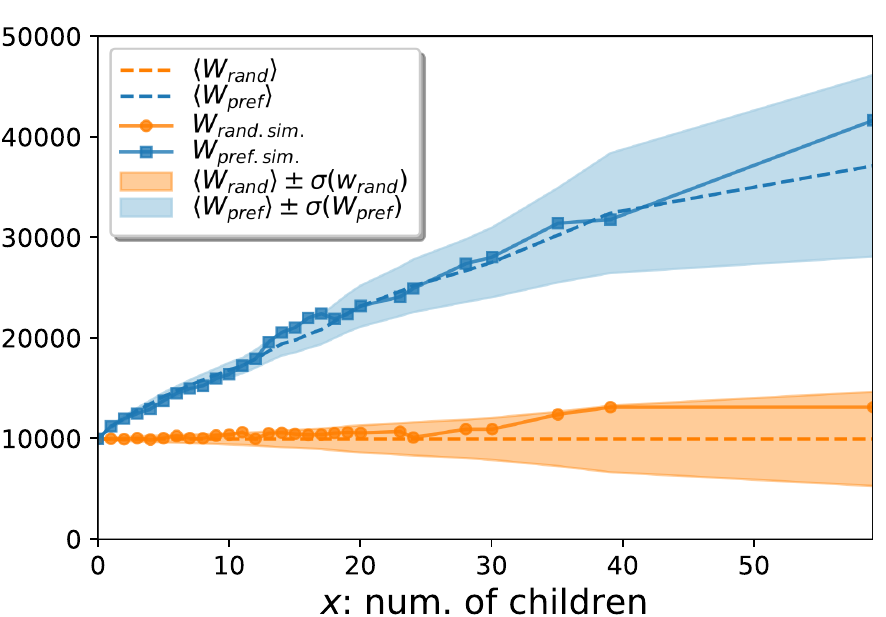
Fig 2. Testing W ( x ) by simulated attachments. The property x here corresponds to the number of children, and the full symbols connected by continuous lines show the measured W ( x ) for random attachment (independent of x ) in orange (circles), and for preferential attachment with an additive constant (i.e. when a newly added node connects to where a is an arbitrary constant) in blue (squares). Dashed lines correspond to the node i with a probability k i þ a P þ a i k i analytic mean for W ( x ), whereas the shaded areas indicate the standard deviation around the